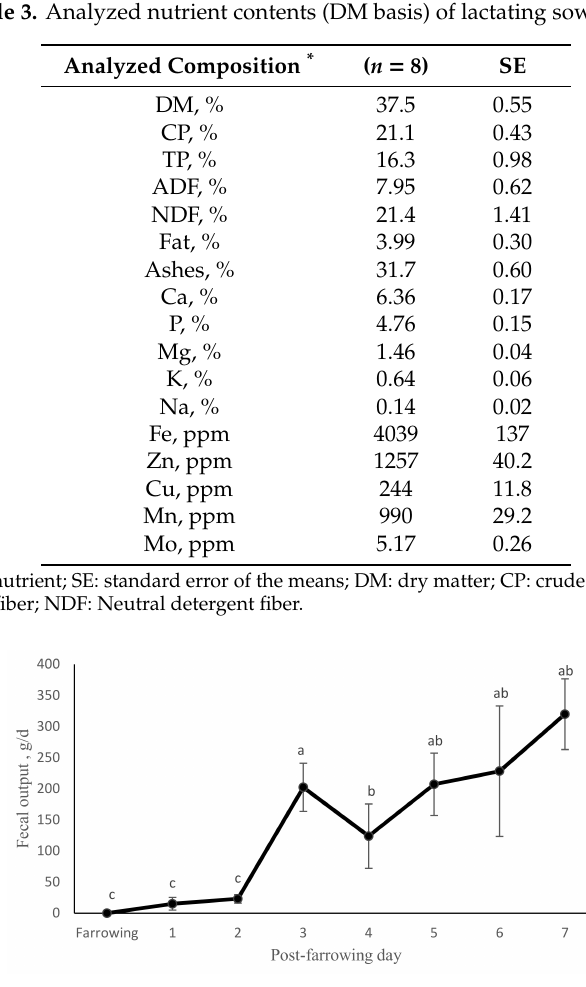
Figure 2. Fecal output (DM basis) ± standard errors (SE) of sows ( n = 8) after farrowing. The data presented are least square means ± SE and represent the best estimate of means that was obtained using repeated measurements. Days with di ff erent superscripts are significantly di ff erent from each other based on Friedman test ( p <